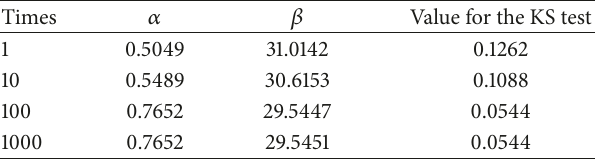
Table 3: Parameters 𝛼,𝛽 , and the KS statistic value by the direct search technique (Initial parameters 𝛼 = 0.5, 𝛽 = 𝑥 = 31.06